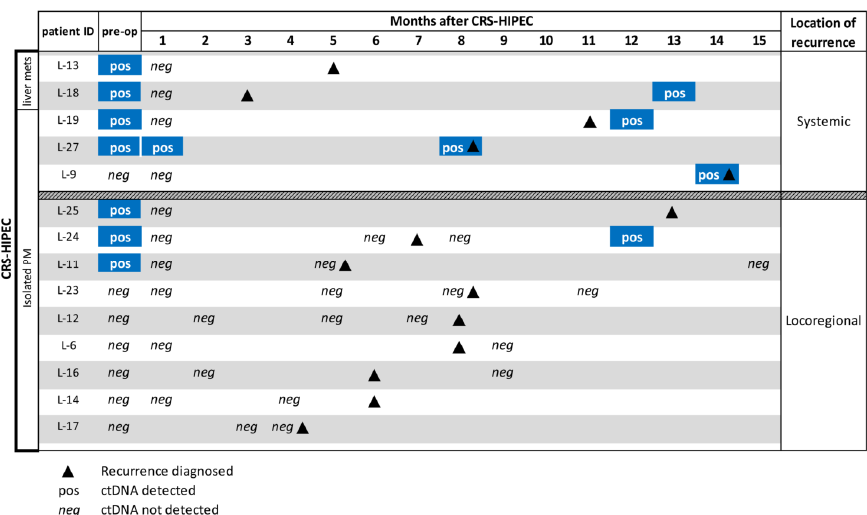
Figure 4. Tissue-guided ctDNA analysis of plasma samples taken from 14 / 24 patients during follow-up after CRS-HIPEC. Ten patients did not provide a sample. Patients are categorized by the location of metastases before or during CRS-HIPEC and the location of recurrence(s) during follow-up. The blue color is to highlight a positive result.